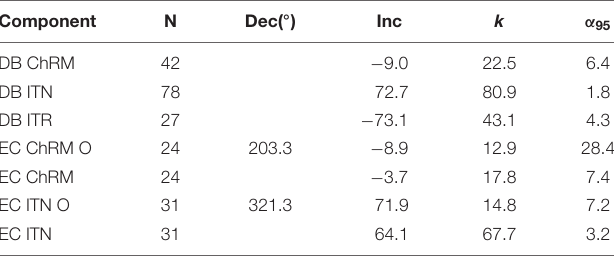
TABLE 1 | Summary of paleomagnetic